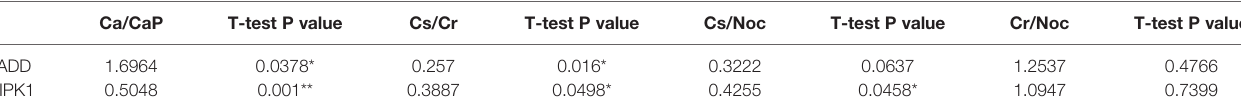
TABLE 3 | Expression of FADD and RIPK1 in different groups of hypo pharyngeal carcinoma.